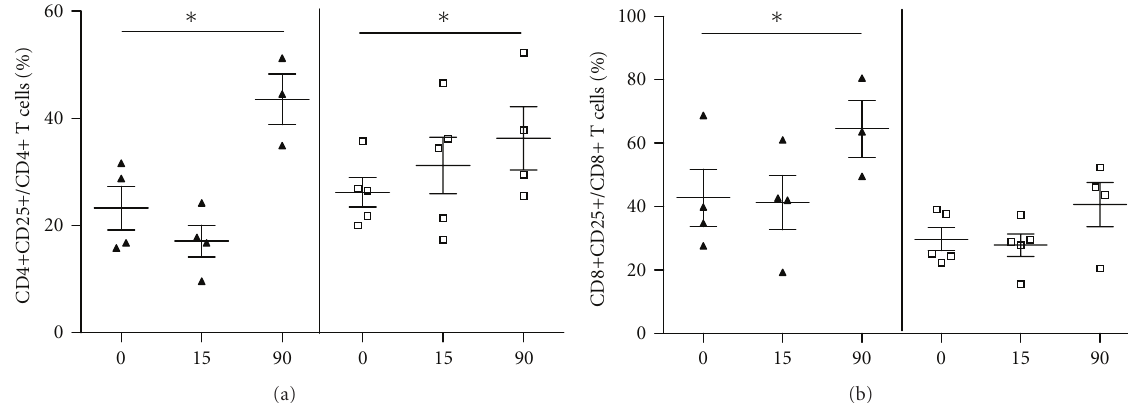
Figure 3: Percentages of the activated lymphocyte cell subsets CD4+ (a) or CD8+ (b) of PBMCs stimulated with PPDB from animals inoculated with Mb Δ mce2 (white square) or NCTC 10772 (black triangle). The means ± SEM are indicated. ∗ statistically significant P < 0 .